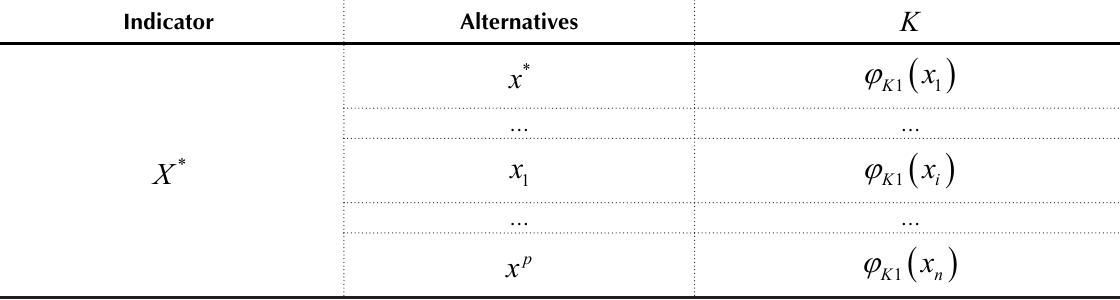
Table 3. Ranked list of alternatives from worst to best